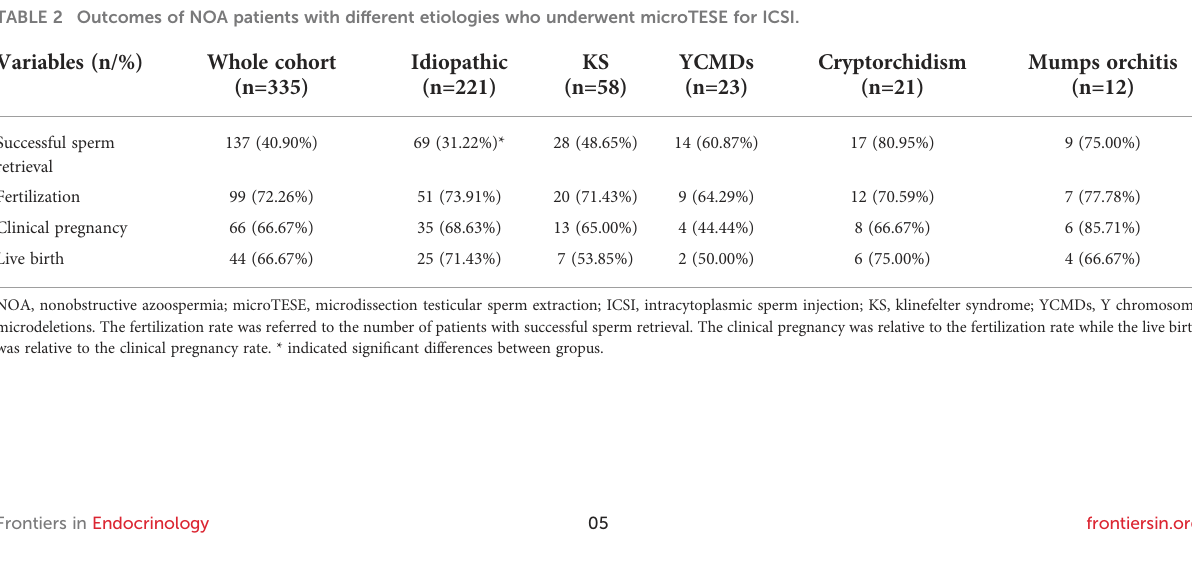
TABLE 2 Outcomes of NOA patients with different etiologies who underwent microTESE for ICSI. Variables (n/%)